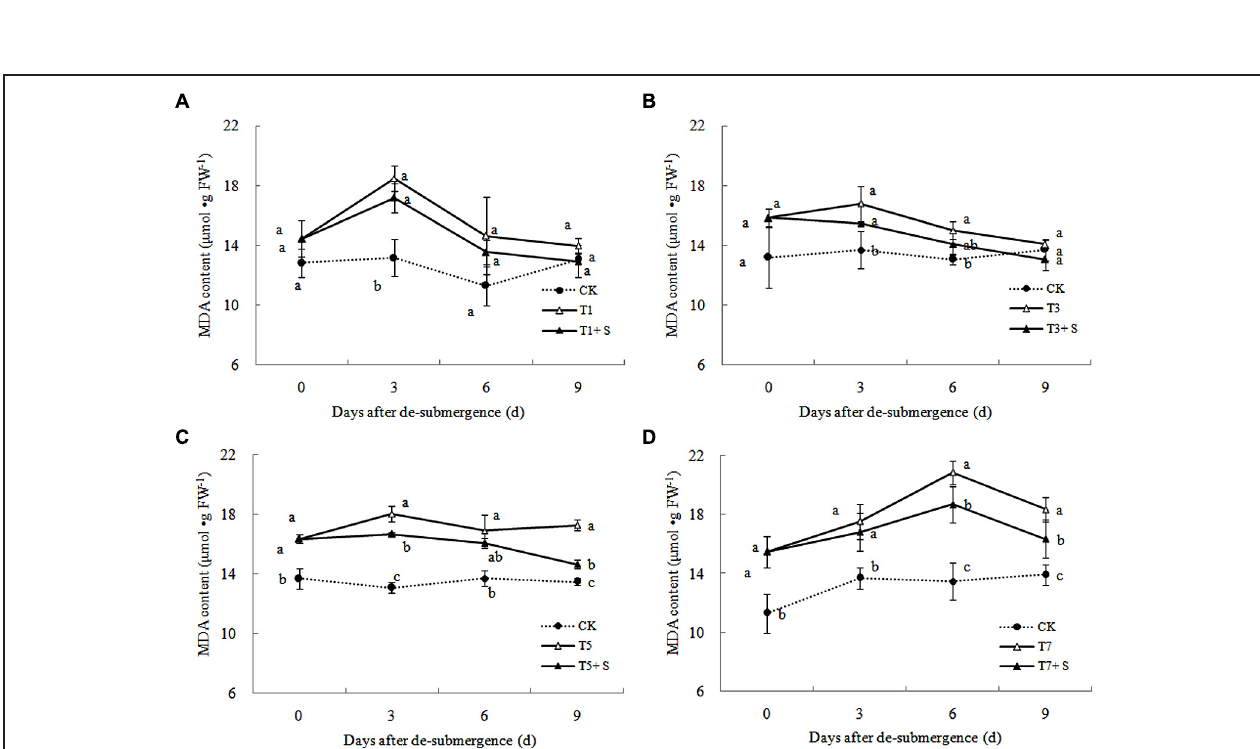
FIGURE 9 | Effects of Spd on malondialdehyde (MDA) content of rice after submergence.